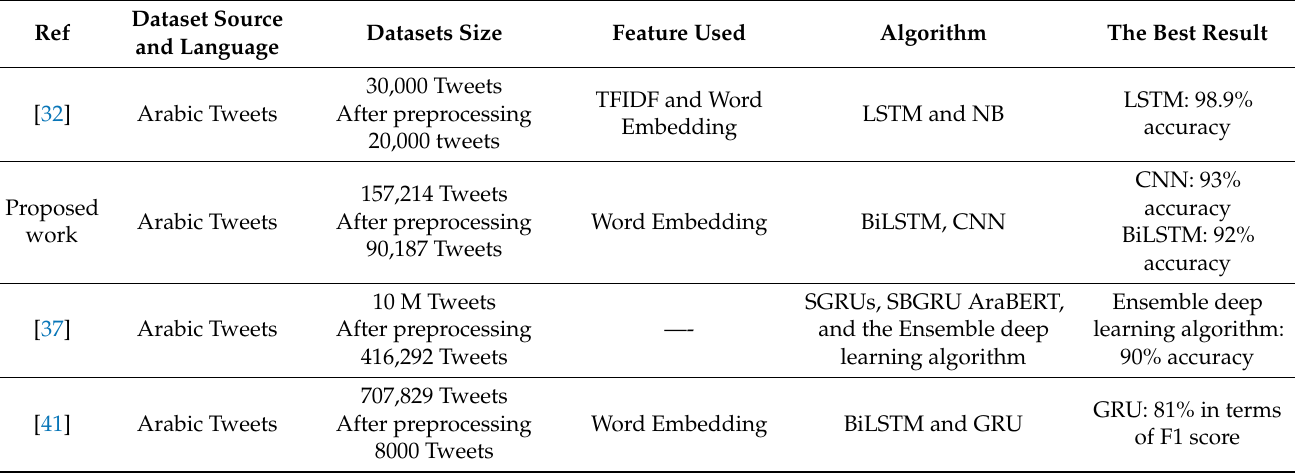
Table 12. Comparison between Proposed CNN and BiLSTM with Previous Studies in the same Fields (COVID-19